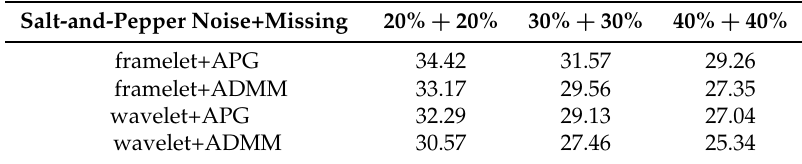
Table 1. Peak signal-to-noise ratios (PSNRs) for the lena image with different levels of salt-and-pepper noise and data missing.